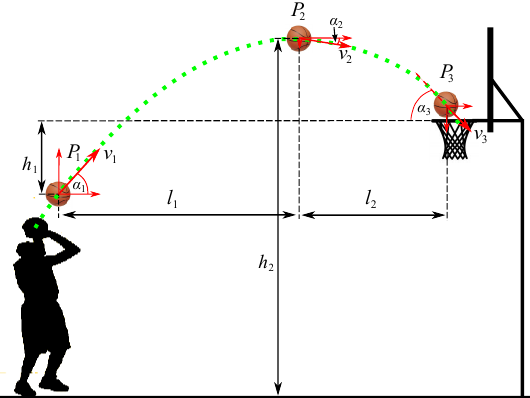
Figure 3. Analysed parameters of a basket throw; h 1 [m]—height between ball and basket, h 2 [m]—height of ball parabola, l 1 [m]—distance between 1st and 2nd point, l 2 [m]—distance between 2nd and 3rd point, v 1 [m/s]—velocity of ball in 1st point, v 2 [m/s]—velocity of ball in 2nd point, v 3 [m/s]—velocity of ball in 3rd point, α 1 [ ◦ ] —angle of ball in 1st point, α 2 [ ◦ ] – angle of ball in 2nd point, α 3 [ ◦ ] —angle of ball in 3rd